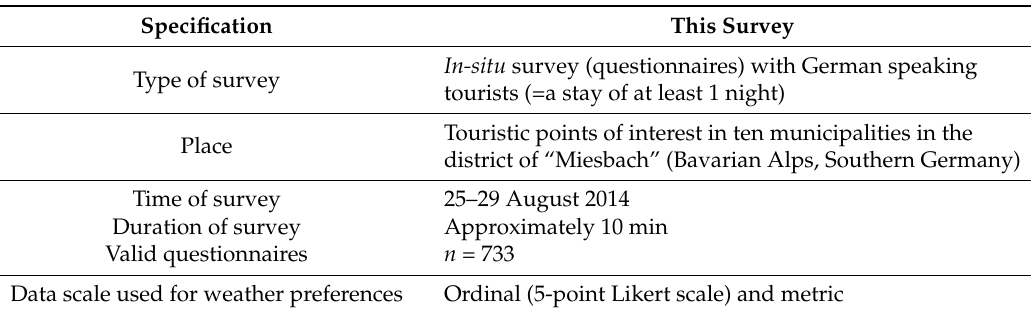
Figure 1. Survey region. Table 1. Technical specifications of the survey.